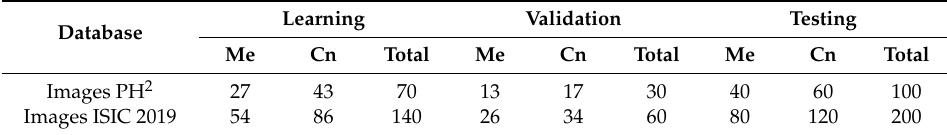
Table 1. The number of images used for experimental results (Me – melanoma, Cn – common nevi).